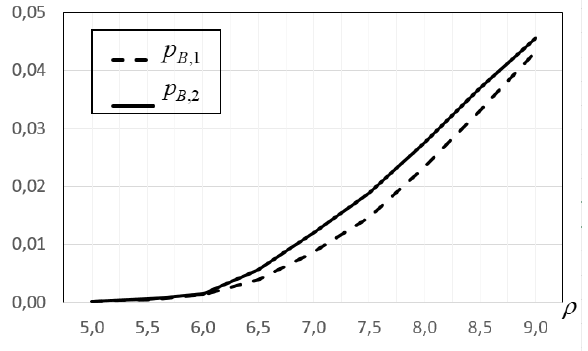
Fig. 1 . The probability that a customer will be blocked on arrival as a function of system load